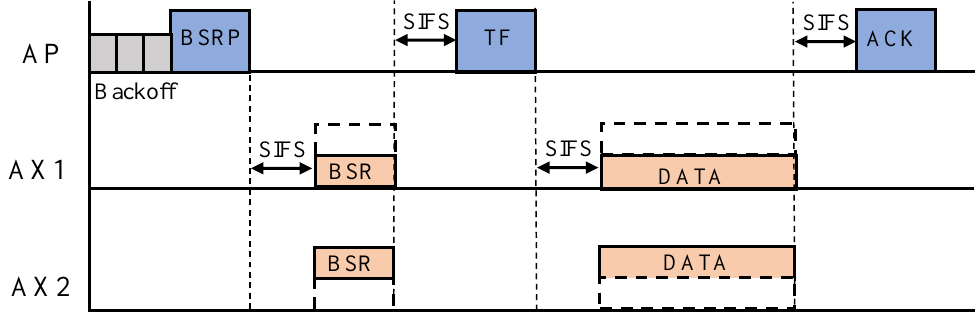
Figure 1. Uplink OFDMA in 802.11ax. The AP sends a BSRP frame to obtain the buffer status of the users, and they respond with BSR frames. The AP then announces the OFDMA scheduling result via a TF, and actual OFDMA data transmission